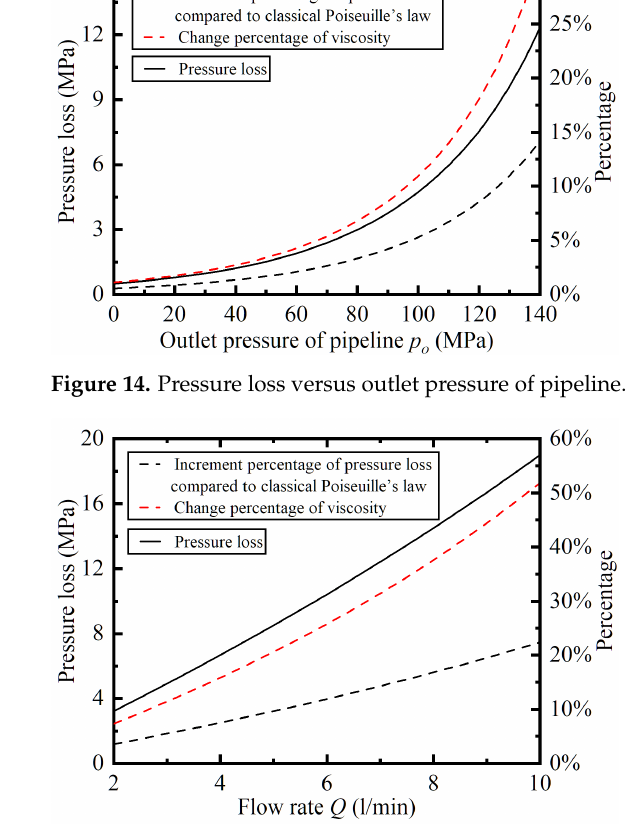
Figure 15. Pressure loss versus flow